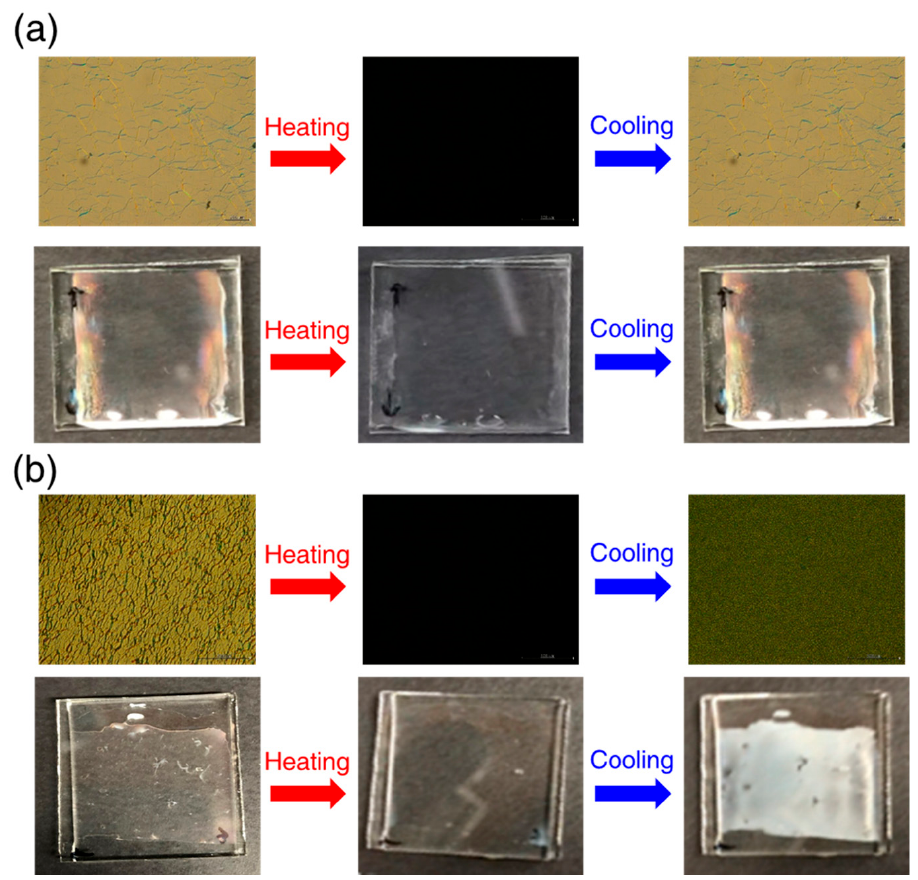
Figure 2. Phase transition behaviors during heating and cooling processes: ( a ) N* LC (2.0) elastomer and ( b ) l-LCP.